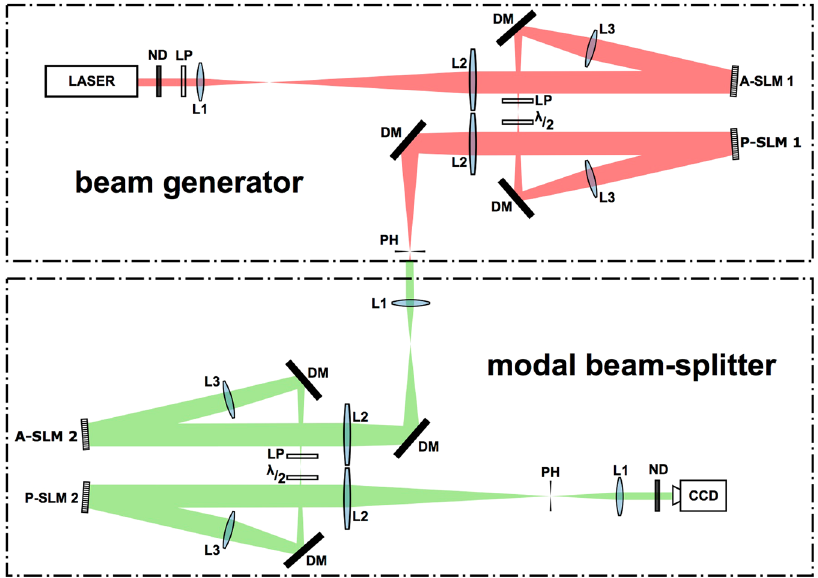
Figure 5. Experimental measurements of four Laguerre-Gaussian beams filtered with the single eigenmask. Sub plots ( a – d ) show the recorded image for the respective beams (P-number, L-number): (0, 0), (1, 0), (0, 1), and (1, 1). Red crosses mark the positions that should not be irradiated, blue circles indicate the positions that of unity